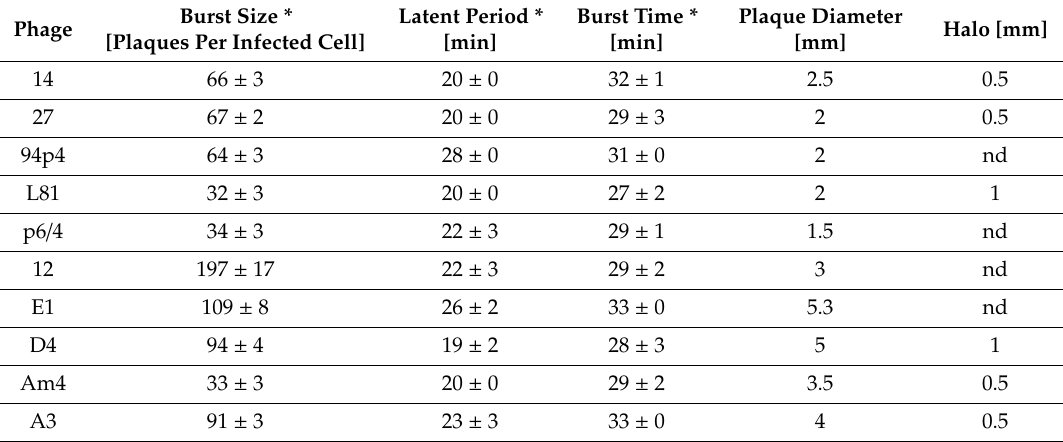
Table 3. Phage infection parameters calculated from one-step growth curves.